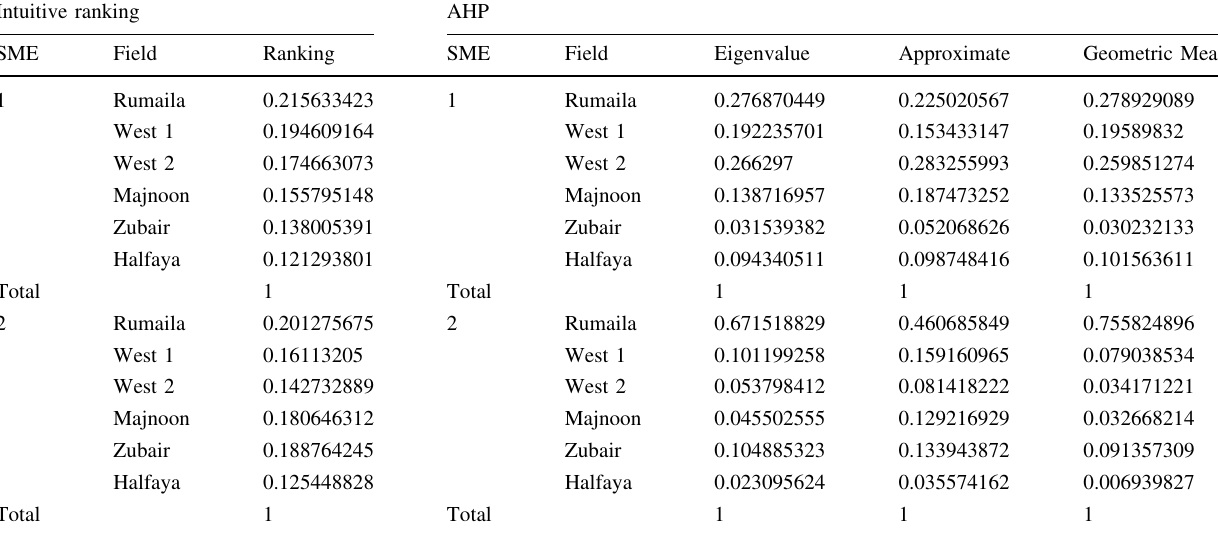
Table 16 Normalized ranking results